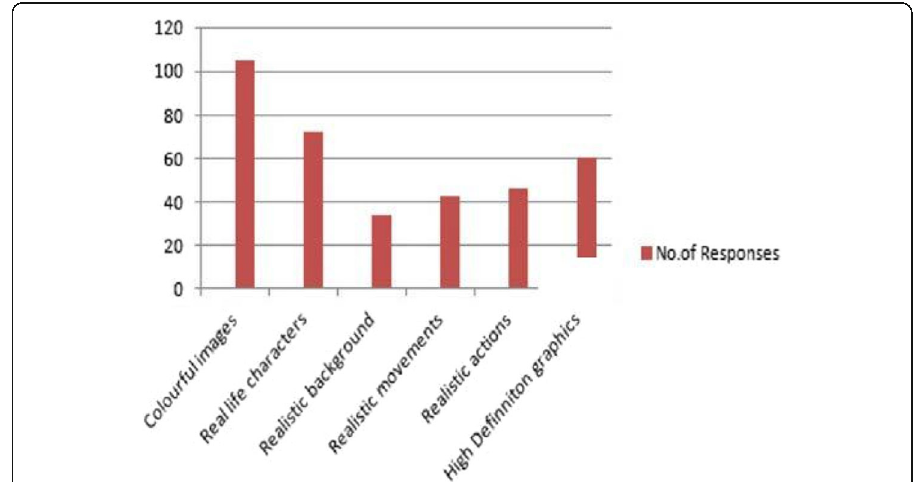
Fig. 2 Number of responses showing the detailed attributes corresponding to realistic.